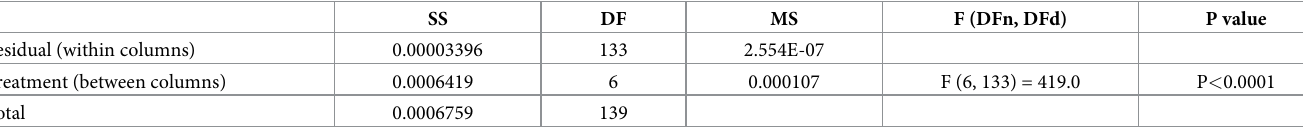
Table 9. ANOVA test results for the proposed algorithm versus state-of-the-art algorithms. SS DF MS F (DFn, DFd) P value